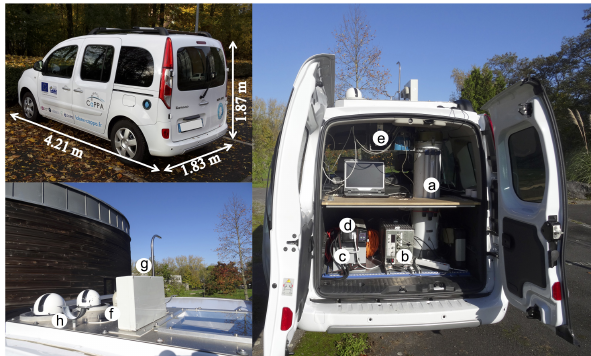
Figure 1. Mobile system and equipment: (a) lidar transmitter– receiver optical head, (b) lidar control and acquisition unit, (c) bat- tery, (d) sine-wave inverter charger, (e) aerosol spectrometer, (f) me- teorological probe, (g) isokinetic sampling probe and (h) PLASMA sun